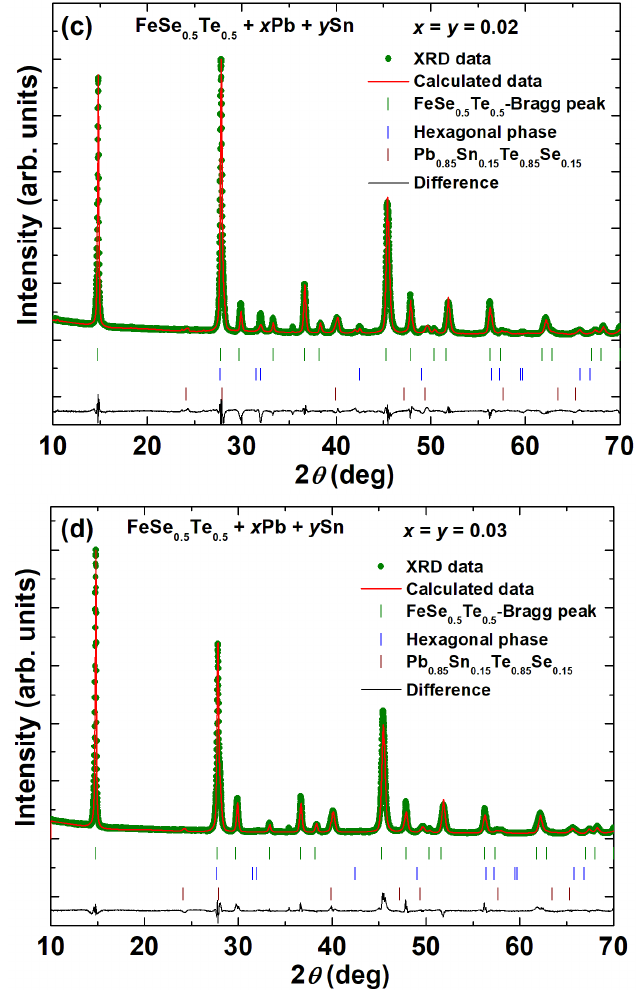
Figure 1. ( a ) X-ray di ff raction pa tt erns (XRD) of powdered FeSe 0.5 Te 0.5 + x Pb + ySn ( x = 0, 0.01, 0.02, 0.03, 0.04, 0.05, and 0.1) samples. The fi tt ed XRD pa tt erns with the experimental, calculated di ff raction pa tt erns and their di ff erences at room temperature are shown for the sample with ( b ) x = y = 0.01, ( c ) x = y = 0.02 ( d ) x = y = 0.03. Instead of the nominal composition of FeSe 0.5 Te 0.5 , the tetragonal phase of Fe 1.1 Se 0.5 Te 0.5 was observed as the real composition of the superconducting phase. One hexagonal phase, Fe 7 Se 8 , was left out in the re fi nement because of relatively weak re fl ections, whereas a hexagonal phase of Fe 0.6 Se 0.54 Te 0.46 (~4–5%) was found and is depicted as ‘H’ in fi gure ( a ). The list